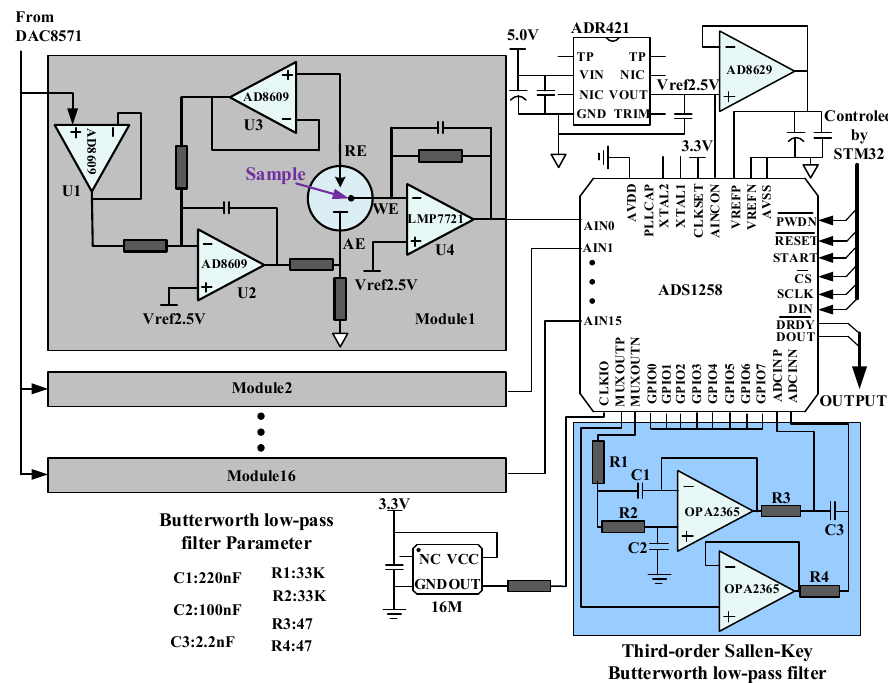
Figure 6. Multi-channel measurement circuit diagram.